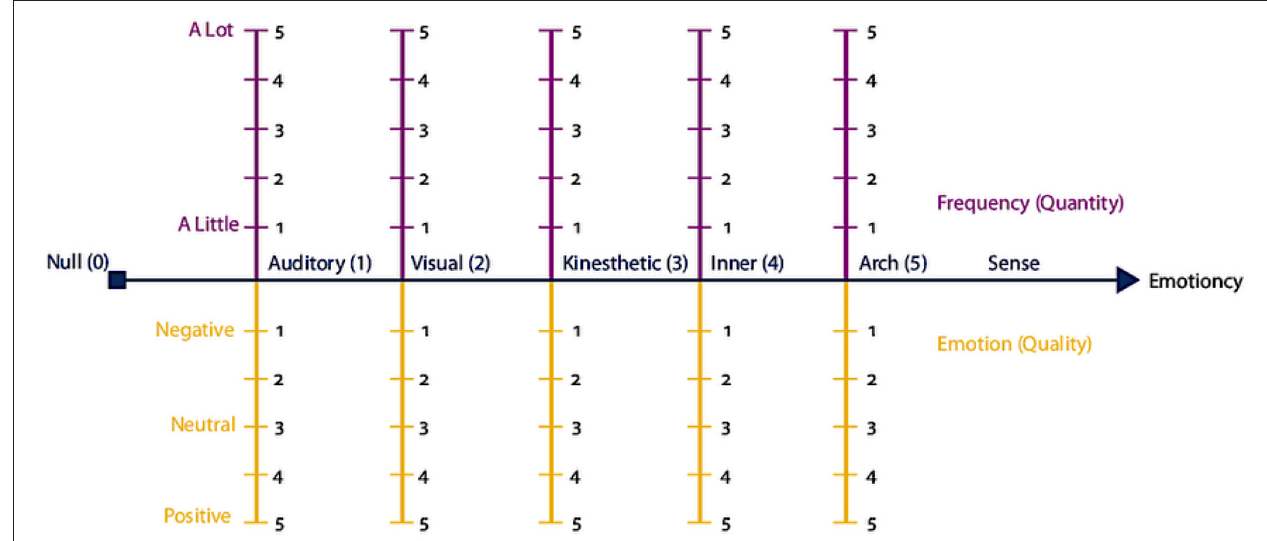
FIGURE 2 | Emotioncy metric. Adapted from Pishghadam